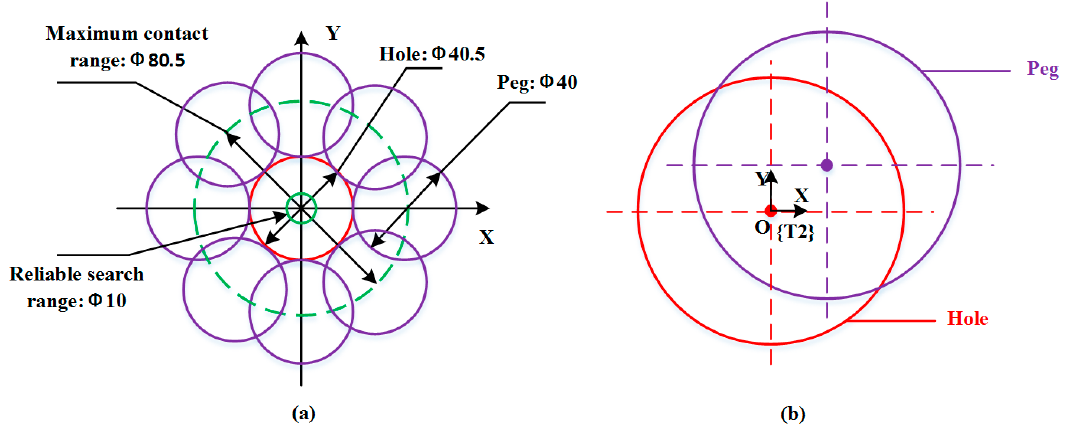
Figure 7. Position adjustment strategy: ( a ) a random search method; ( b ) dual-arm relative movement.